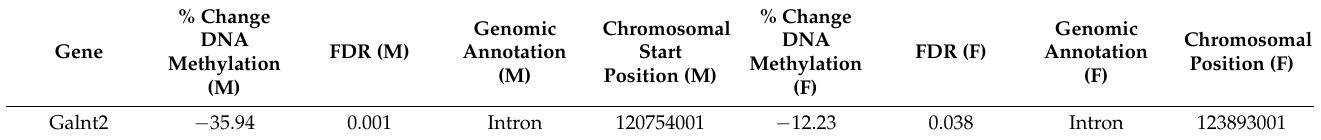
Table 4. DMR-associated gene exhibiting differential DNA methylation in both males and